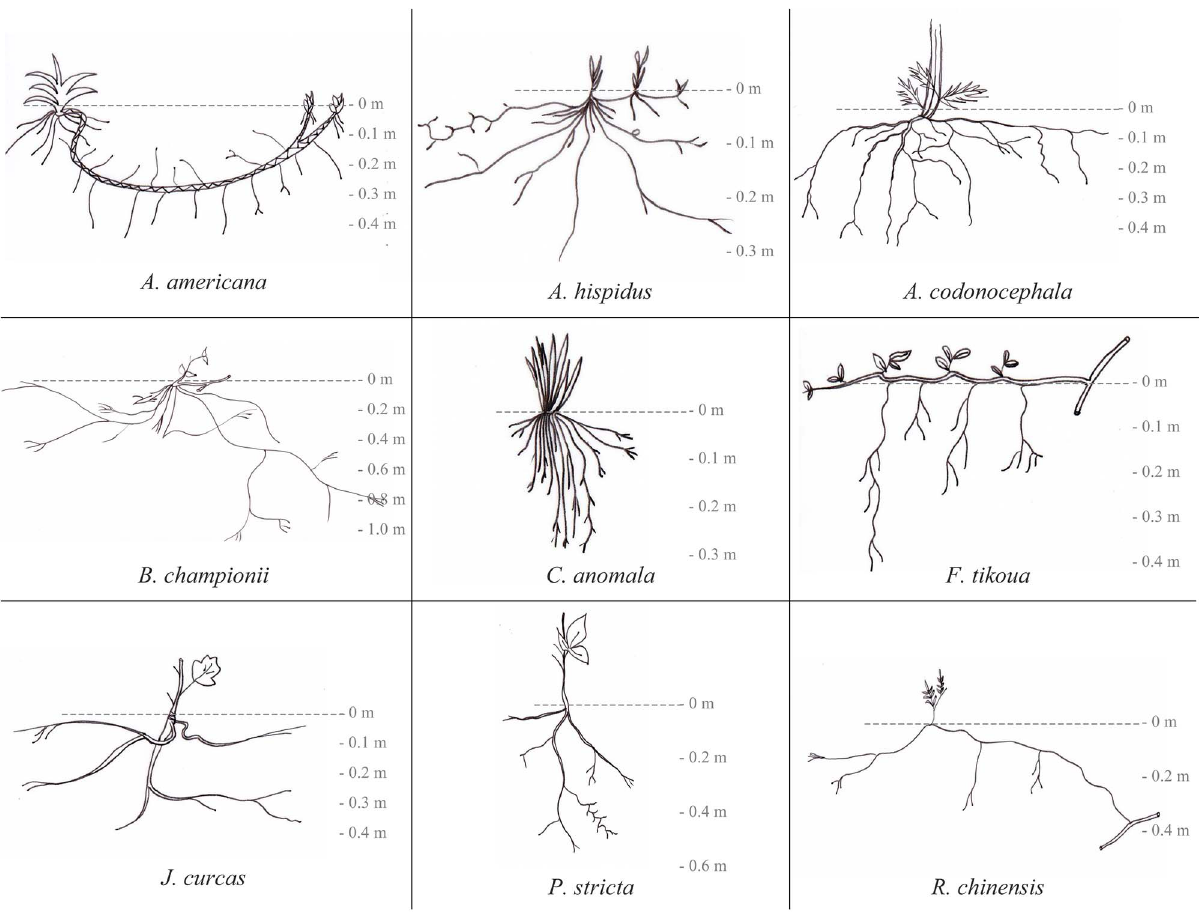
Figure 3. Description of the root systems of the nine studied species. Root systems of the nine species and their rooting depth (m). A. americana ’s root system was composed of an underground stem from which emerged thin roots; A. hispidus ’s root system comprised only a few thin roots emerging from the plant collar; A. codonocephala possessed a root system with long lateral roots turning downwards over time; B. championii had long and deep roots, which deviated on encountering an obstacle and which were densely branched; C. anomala possessed a tufted and shallow root system; vertical roots of F. tikoua emerged from creeping stems; J. curcas and P. stricta both possessed taproot systems, but roots of P. stricta were deeper and more densely branched; R. chinensis had a sprouting root system comprising long, deep and scarcely branched roots. Note that the scale for soil depth (y axis) differs between species for easier viewing.